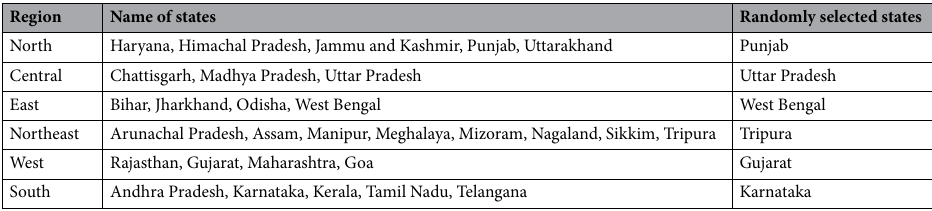
Table 1. Regional classification of Indian